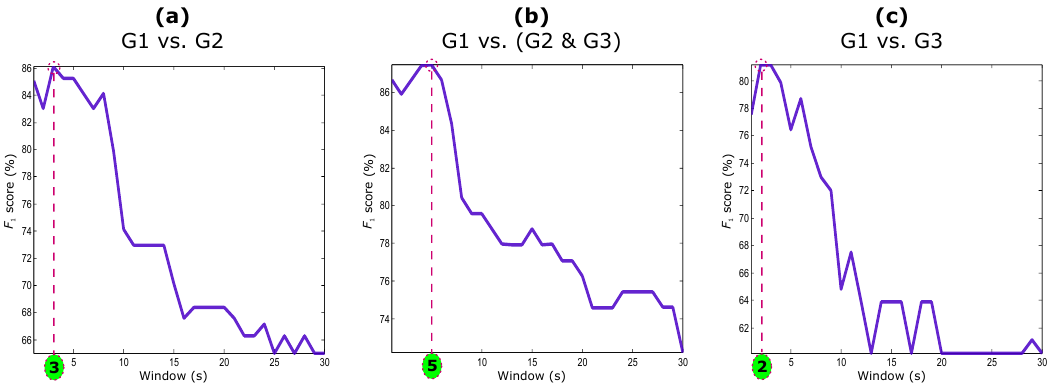
Figure 3. Window size optimization of the optimal signal quality index (skewness [S SQI ]) based on the adjudicated photoplethysmograms. ( a ) excellent PPG signal quality (G1) versus acceptable PPG signal quality (G2); ( b ) G1 versus (G2 and unfit to diagnose PPG signals (G3)); and ( c ) G1 versus